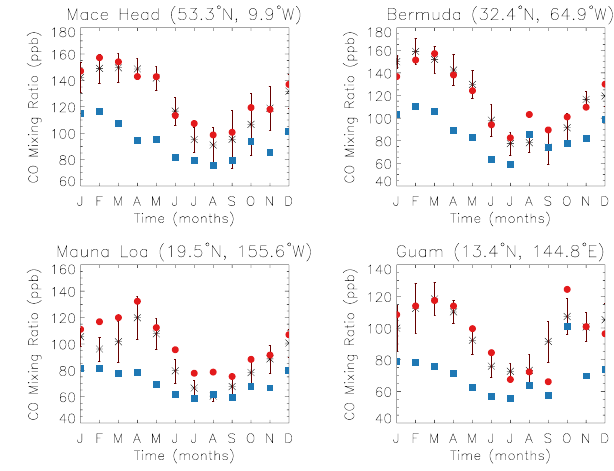
Fig. 9. Cumulative impact of shipping, aviation and the chemical source as a function of latitude. The impacts were determined by subtracting zonally-averaged CO 2 from runs with and without shipping and aviation emissions, and runs with and without the chemical source. The solid lines show the impacts at the surface and the dotted lines show the impacts at the model level near 5km. Runs began with a uniform initialization of 375.0ppm on 1 January 2004.